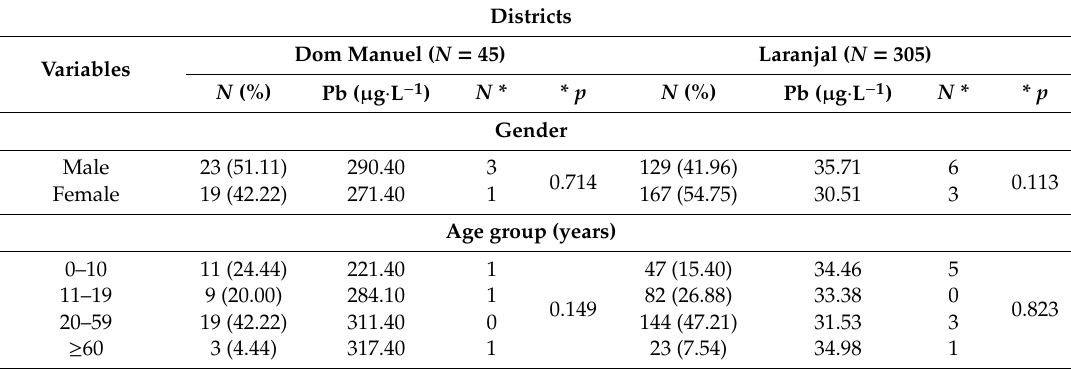
Table A2. Mean Pb levels in the blood, and the demographics and lifestyle of the individuals of Dom Manuel and Laranjal, State of Pará, Brazil, 2012.